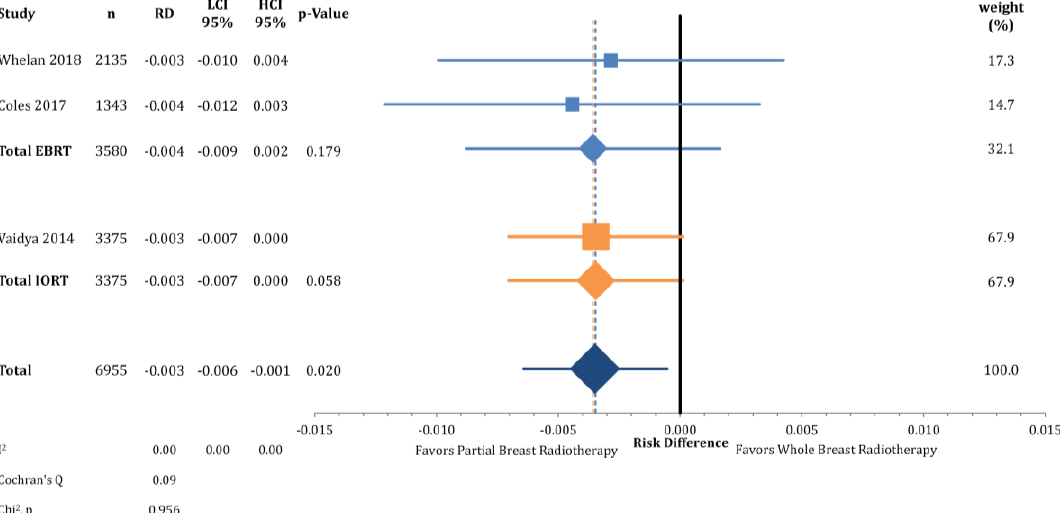
Figure 6. Comparison of cardiac death by risk difference between partial- and whole breast radiation using a forest plot. Trials are grouped by radiation technique. Quadrats and diamonds represent individual trials and pooled effect sizes with corresponding 95% confidence intervals.